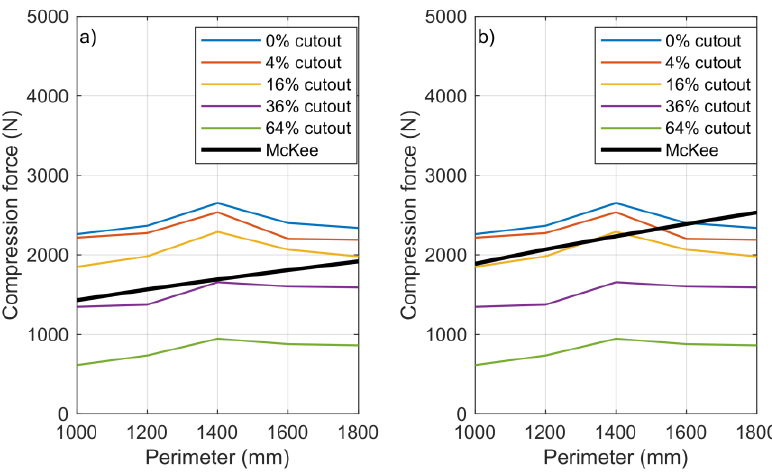
Figure 8. Summary data of BCT values calculated from the McKee equation and measured average BCT values for different cutout rates: ( a ) k = 5.3 and ( b ) k = 7.